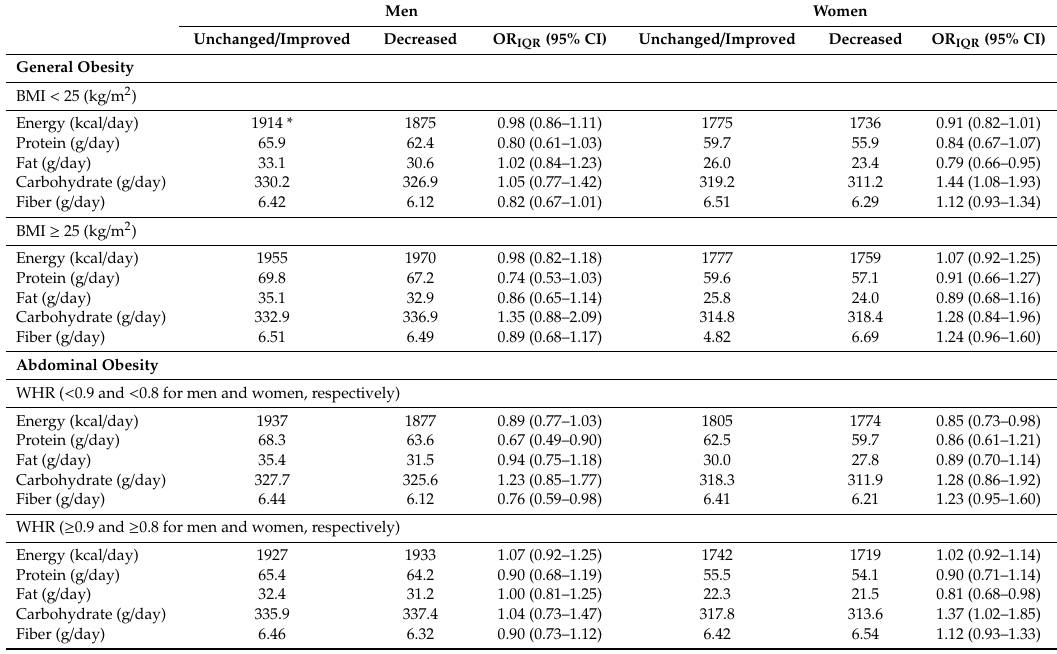
Table 4. The association between macronutrient intake and the lung function by general (BMI) and abdominal (WHR)